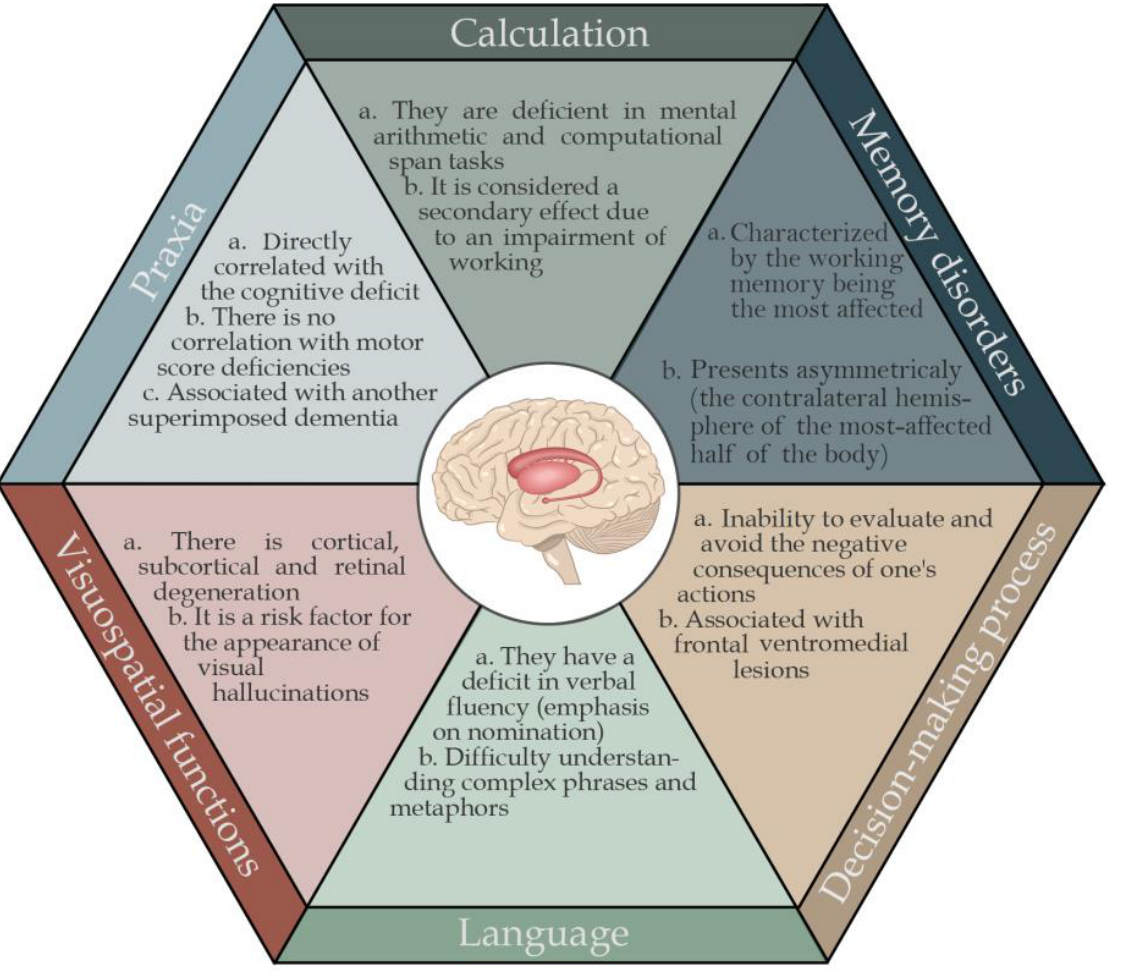
Figure 6. Summary of the characteristic cognitive alterations in Parkinson’s disease.